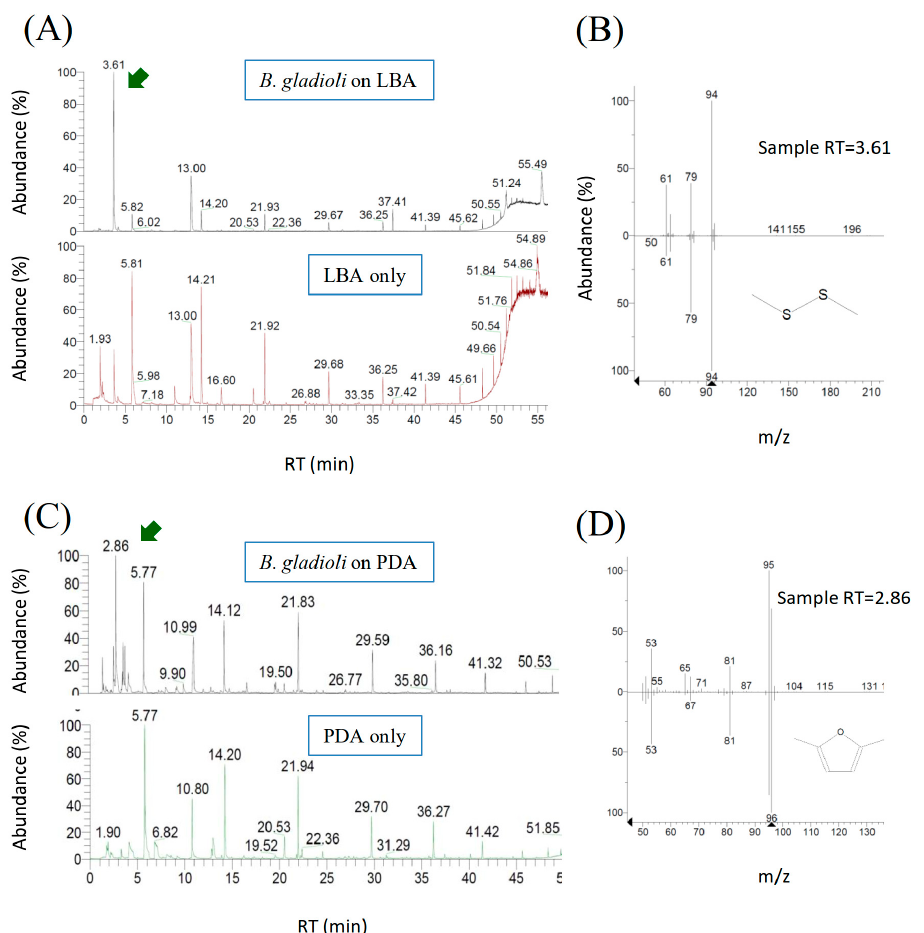
Figure 6. Chemical identification of VOCs emitted by B. gladioli BBB-01. VOCs collected from the headspace of the bacterial culture flask by the SPME fiber was analyzed by GC ( A , C ). The peaks of a retention time (RT) of 3.61 and 2.86 min appeared only when the Burkholderia strain was grown on LBA and PDA, respectively. The two unique peaks were further analyzed by mass spectrometry, and the fragmentation patterns match that of dimethyl disulfide ( B ) and 2,5-dimethylfuran ( D ), respectively, according to the NIST database.